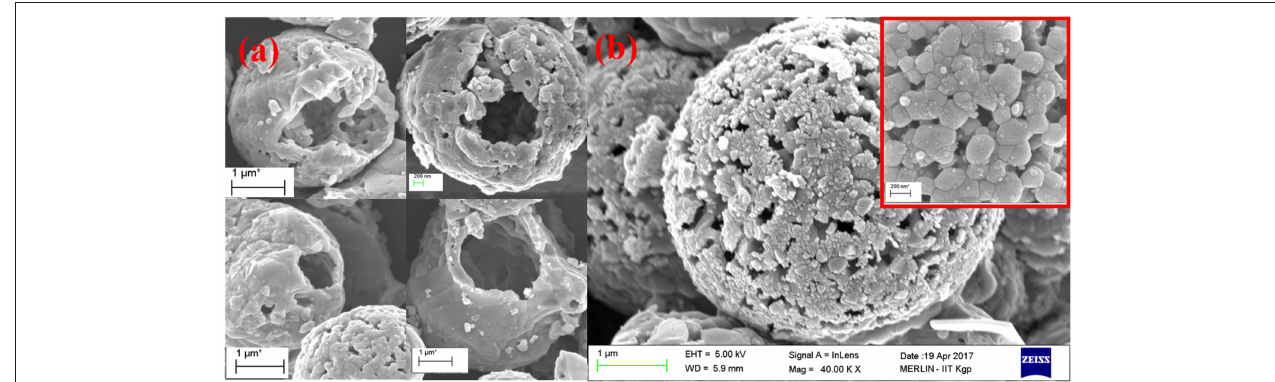
FIGURE 1 | (a) SEM image showing uniform microsphere, (b) SEM confirms porous and hollow structure.